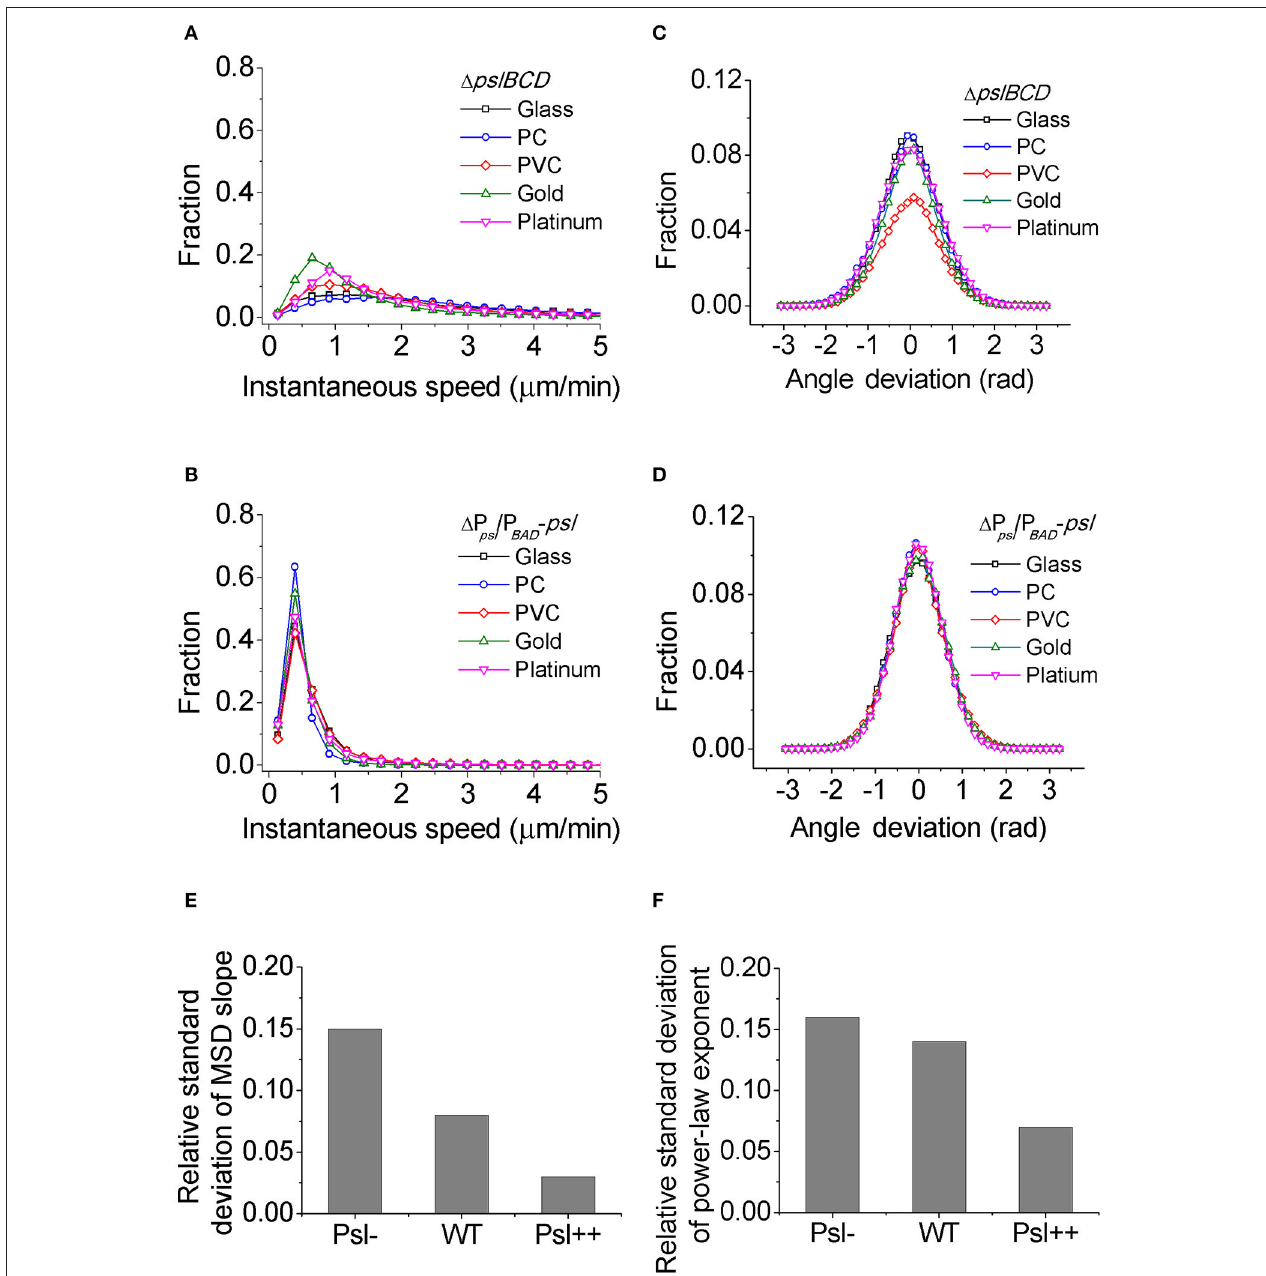
FIGURE 4 | The distributions of speed and angle deviation, the relative standard deviations of MSD slope and power-law exponent for different strains. (A) and (B) are speed distributions for Psl- ( 1 pslBCD ) and Psl ( 1 P psl /P BAD - psl with 1% (w/v) arabinose addition in the medium), respectively. (C) and (D) are angle deviation ++ distributions for Psl- and Psl , respectively. (E) and (F) are the relative standard deviations of MSD slope and power-law exponent, respectively, for Psl-, WT and ++ Psl ++